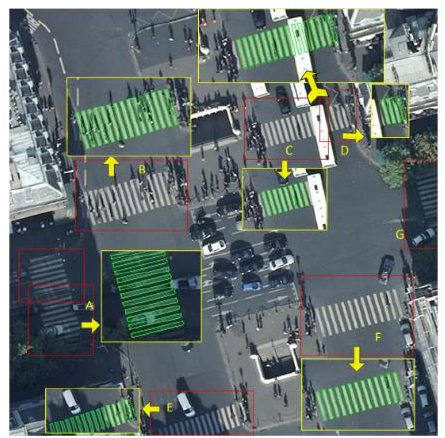
Figure 17. The results of zebra crossing reconstruction in green lines.